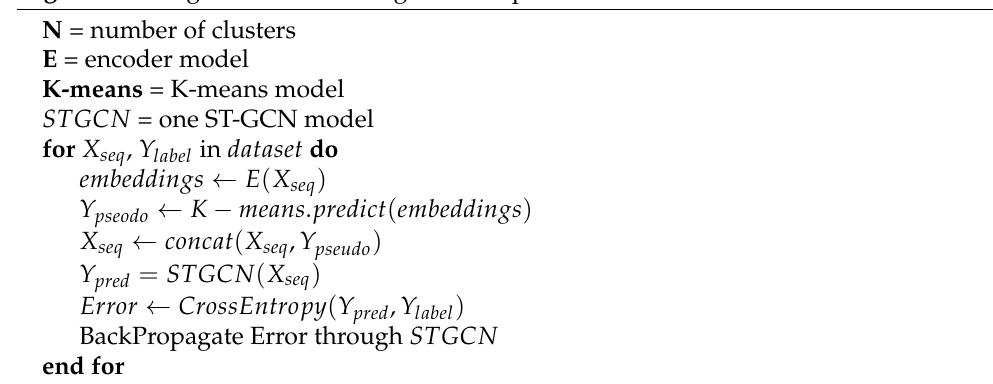
Algorithm 2 Algorithm for training of the improved architecture.